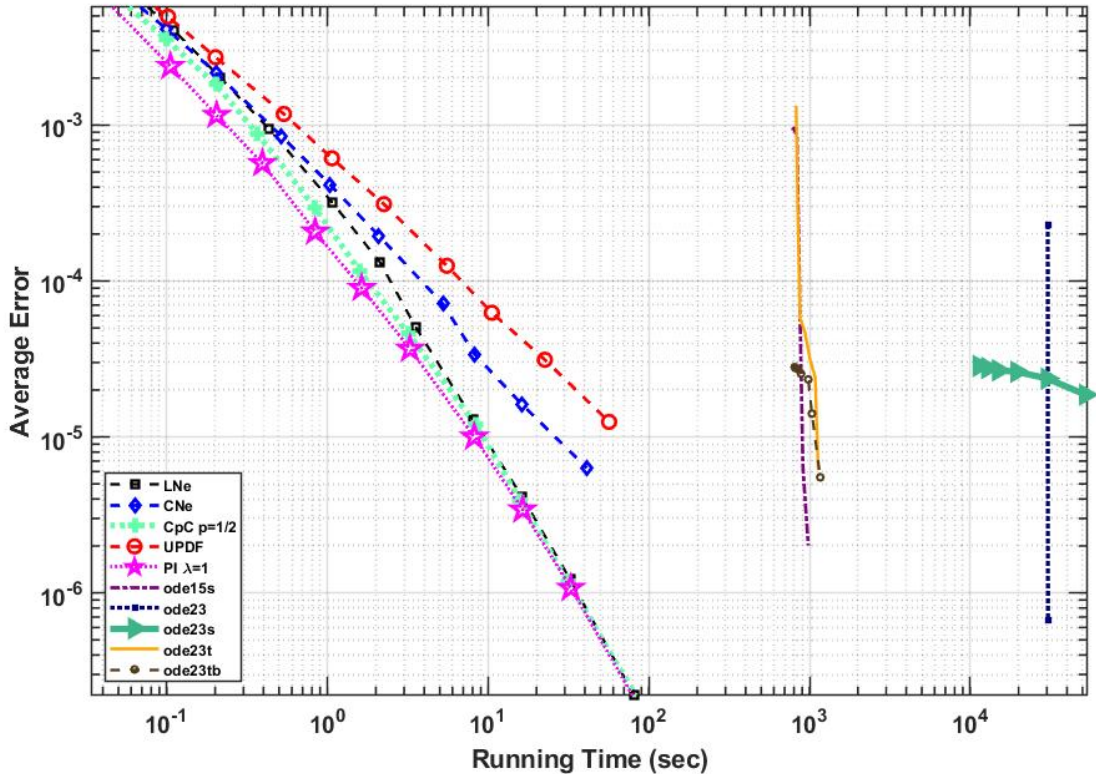
Figure 4. (average) errors as a function of the running time for the first (moderately stiff) system, in the case of the algorithms coded by us as well as of the MATLAB routines. Table 1. Comparison of different algorithms for the extremely stiff system of twelve thousand cells. Numerical Method